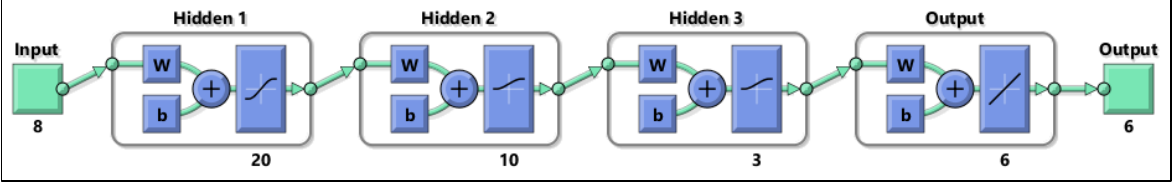
Figure 3. Schematic for neural network(s) in Neuro-Simulation Part